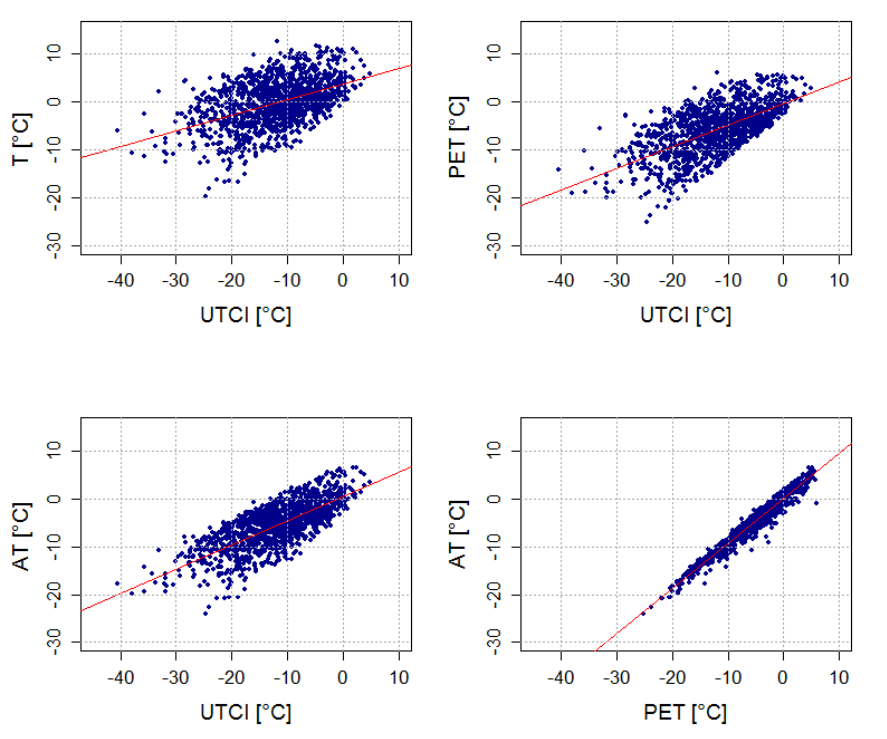
Figure 4. Linear regression between mean daily UTCI, PET, AT, and T in the urban (Prague) region in winter over 1994–2009. Coefficients of determination are shown in Table